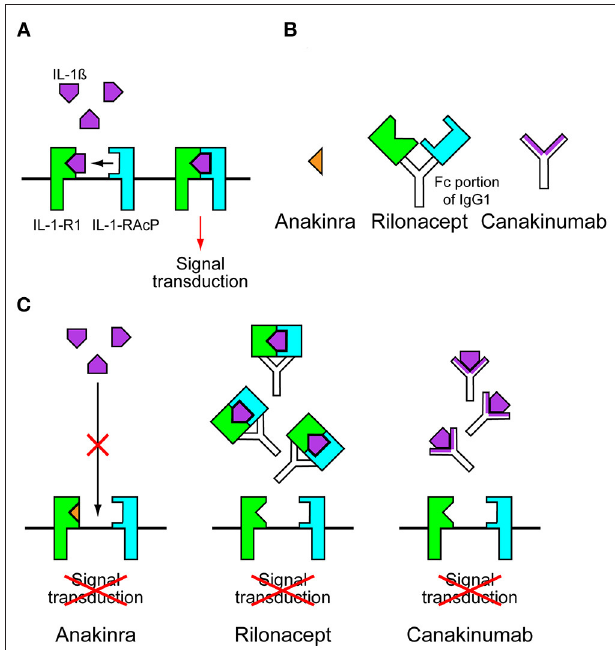
FIGURE 2 | Anti-interleukin-1 drugs. (A) Interleukins-1 β (IL-1 β ) activates cells by binding and signaling through IL-1 receptor type 1 (IL-1-R1) and the IL-1 receptor accessory protein (IL-1-RAcP). These receptors form a complex with IL-1 β at the cell membrane for signal transduction. (B) Anakinra is a recombinant form of IL-1-R1 antagonist. Rilonacept is a dimeric IL-1 receptor fusion protein consisting of the extracellular domains of the IL-1-RAcP and the IL-1-R1 fused to the fragment crystallizable (Fc) portion of human immunoglobulin G1 (IgG1). Canakinumab is a specific human monoclonal IgG1 antibody against IL-1 β . (C) In the presence of anakinra, IL-1 β cannot bind to IL-1-R1. In the presence of rilonacept or canakinumab, Il-1 β is trapped before it can reach its receptors, preventing signal